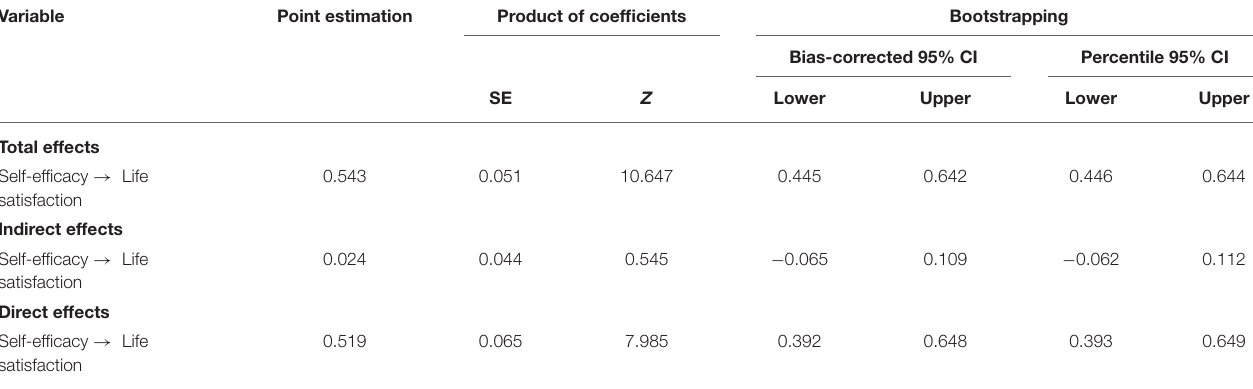
TABLE 4 | Results of the mediating effect of sports